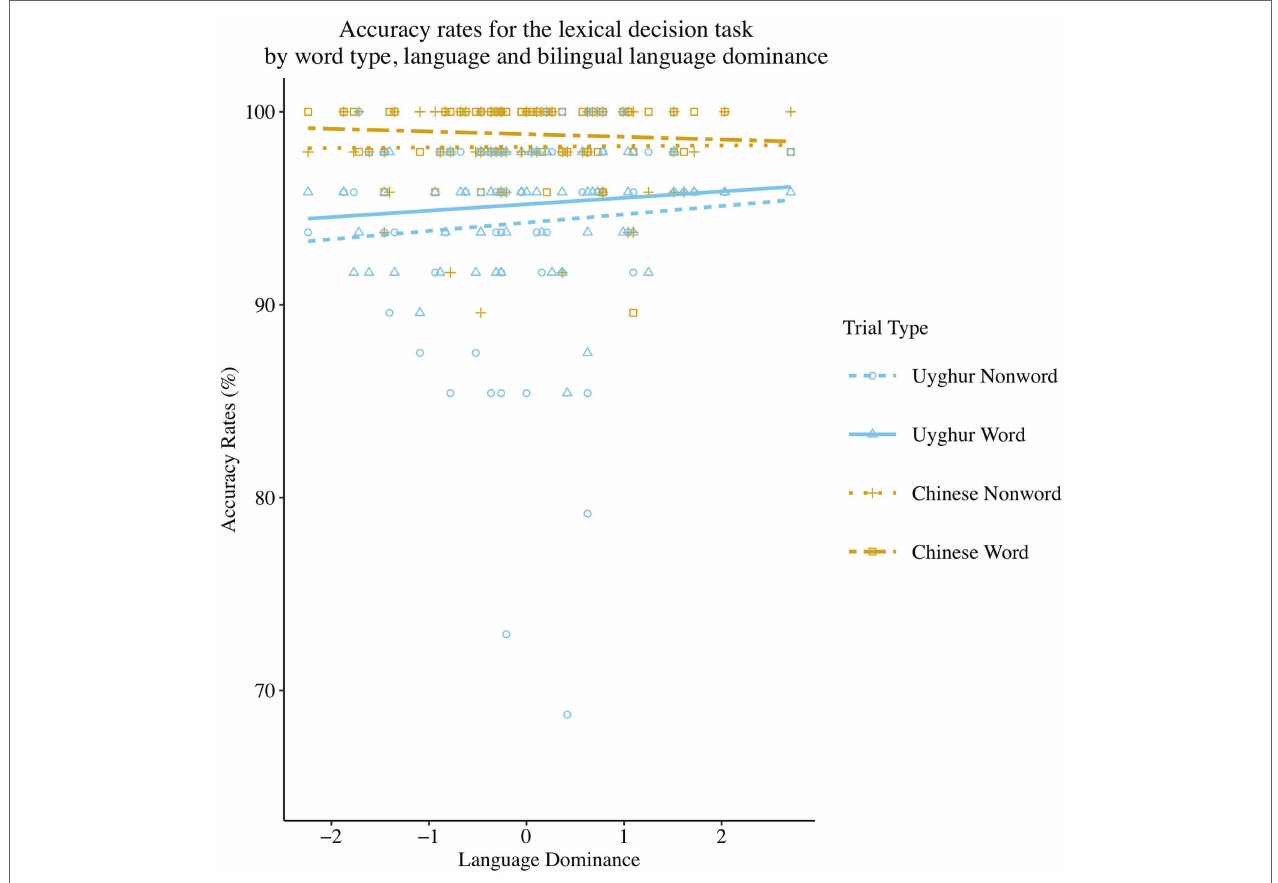
FIGURE 1 | Scatterplot and regression fit lines demonstrating the relationship between Language Dominance and mean accuracy at all the combinations of variables of Language and Word Type in the lexical decision task. The score on the x-axis closer to or above +1 means a higher dominance in L1, while the score closer to or below − 1 means a higher dominance in L2.